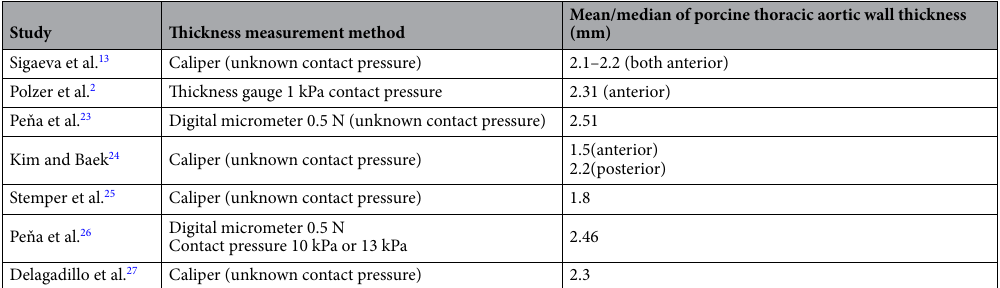
Table 3. Mean or median porcine descending thoracic aorta as reported by various studies.